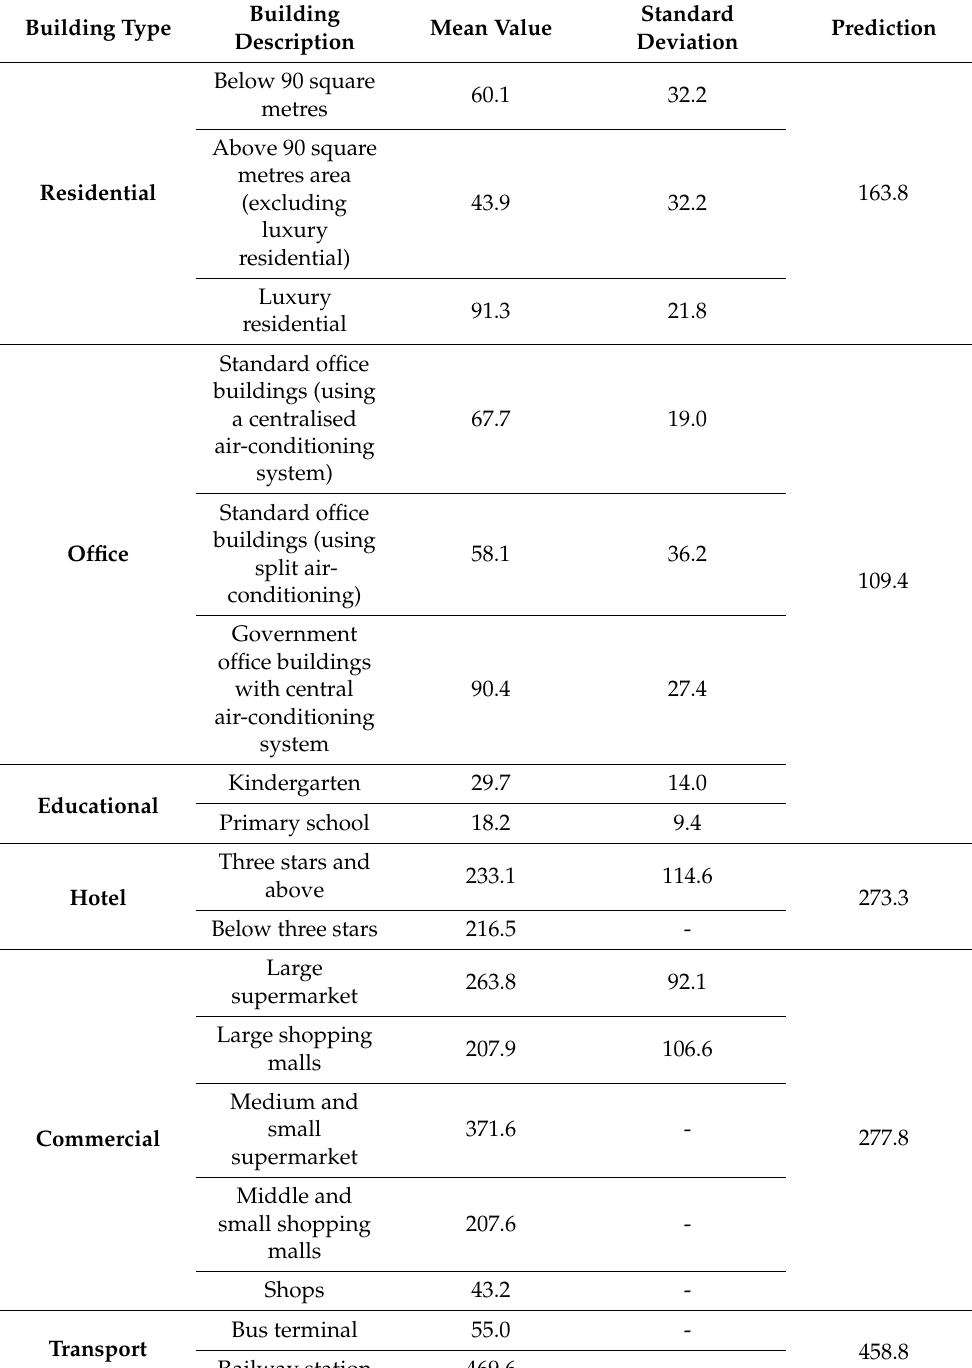
Table 7. Benchmarks of energy demand (kWh/(m 2 · a) in Wuhan